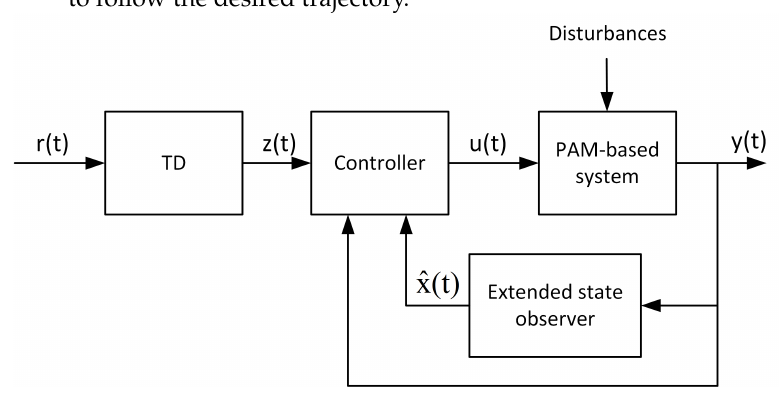
Figure 2. ADRC controller